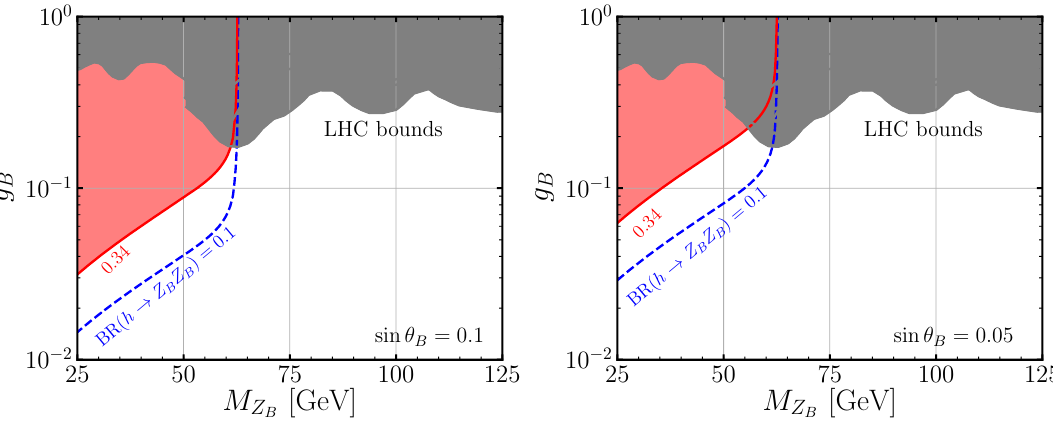
Figure 6 . Exclusion bounds in the g B vs. M Z B plane. The region shaded in red shows the exclusion bounds from the constraint on the SM-like Higgs branching ratio BR( h Z B Z B ) < 0.34, while the ! blue dashed line corresponds to BR( h Z B Z B ) = 0 : 1. The region shaded in gray is excluded by ! searches for the Z B at the LHC. The left (right) panel corresponds to sin (cid:18) B = 0 : 1 (sin (cid:18) B = 0 : 05). g B M Z plane, in the maximal mixing scenario where sin (cid:18) B = 0 : 3 and with center-of- B (cid:0) mass energy of p s = 14 TeV. The region shaded in red is excluded by the experimental bound on the branching ratio of the SM Higgs into BSM particles discussed in the previous section. The di(cid:11)erent colored dotted regions correspond to the predictions in di(cid:11)erent ranges: (cid:27) < 0 : 1 fb (blue dots), 0 : 1 fb < (cid:27) < 1 fb (orange dots), 1 fb < (cid:27) < 10 fb (yellow dots), 10 fb < (cid:27) < 100 fb (cyan dots), and (cid:27) > 100 fb (purple dots). The production